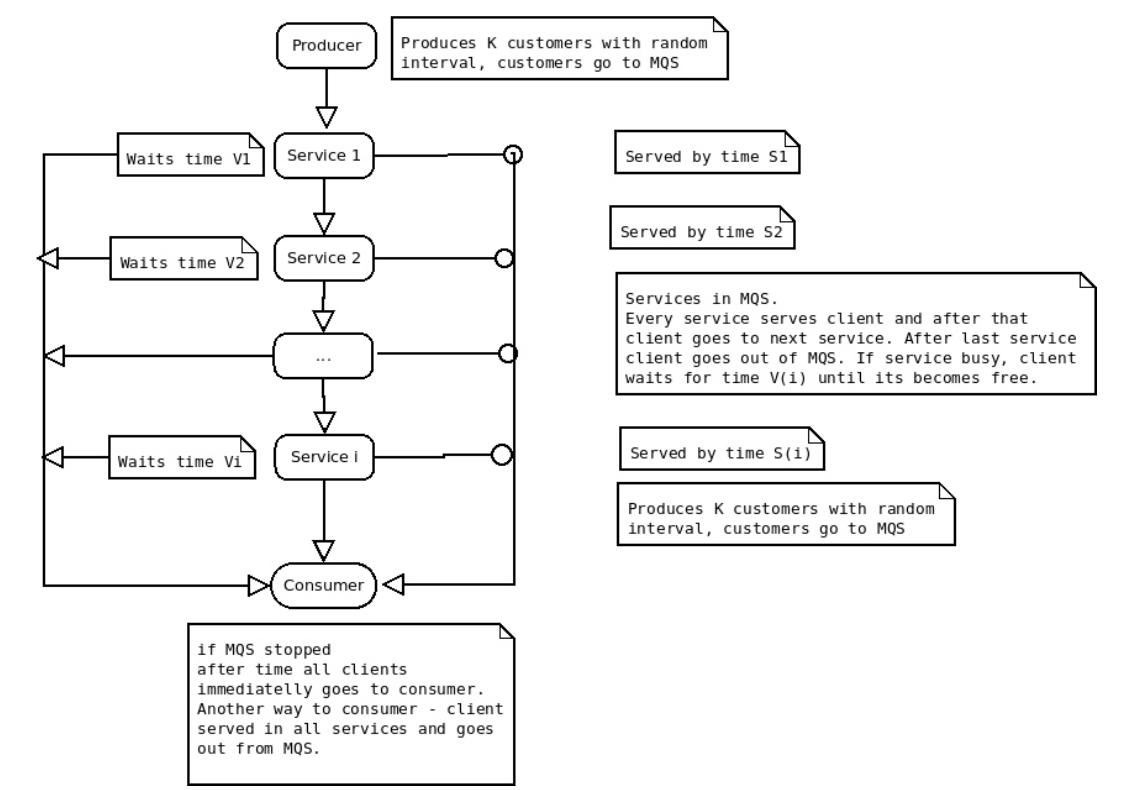
Figure 1. Algorithm of the simulation model.